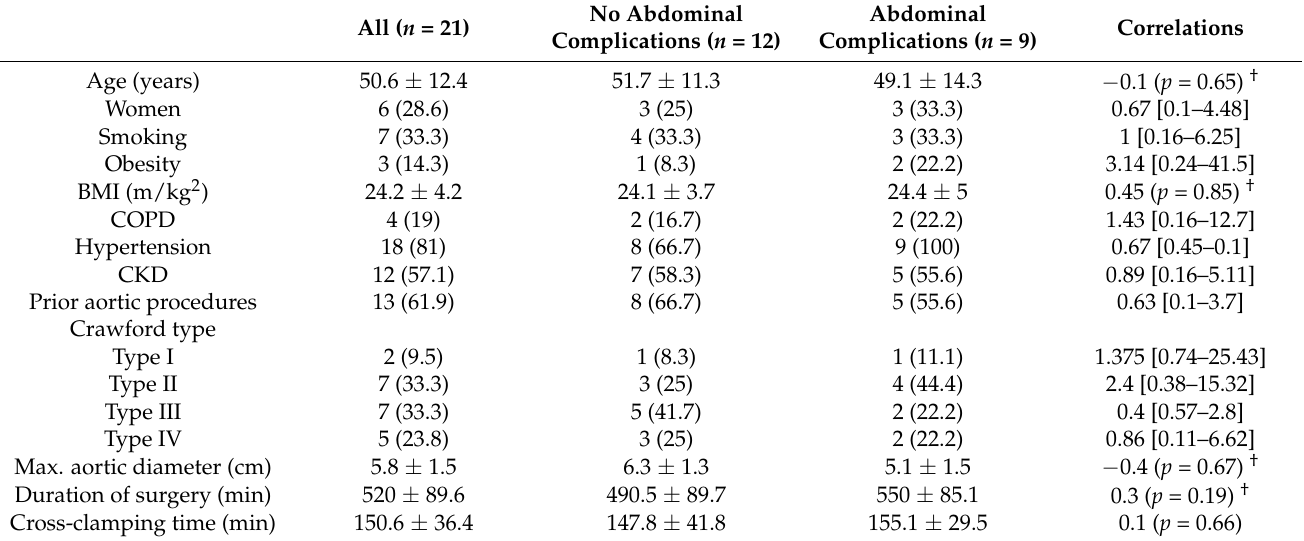
Table 1. Demographic data and procedural details. Values are the number (%) or mean ± SD, as indicated. Correlations are reported with the odds ratio and a 95% confidence interval for categorical variables; however, those indicated with † are continuous variables, which are reported with Pearson’s (r) and p -value; BMI: body mass index; COPD: chronic obstructive pulmonary disease; CKD: chronic kidney